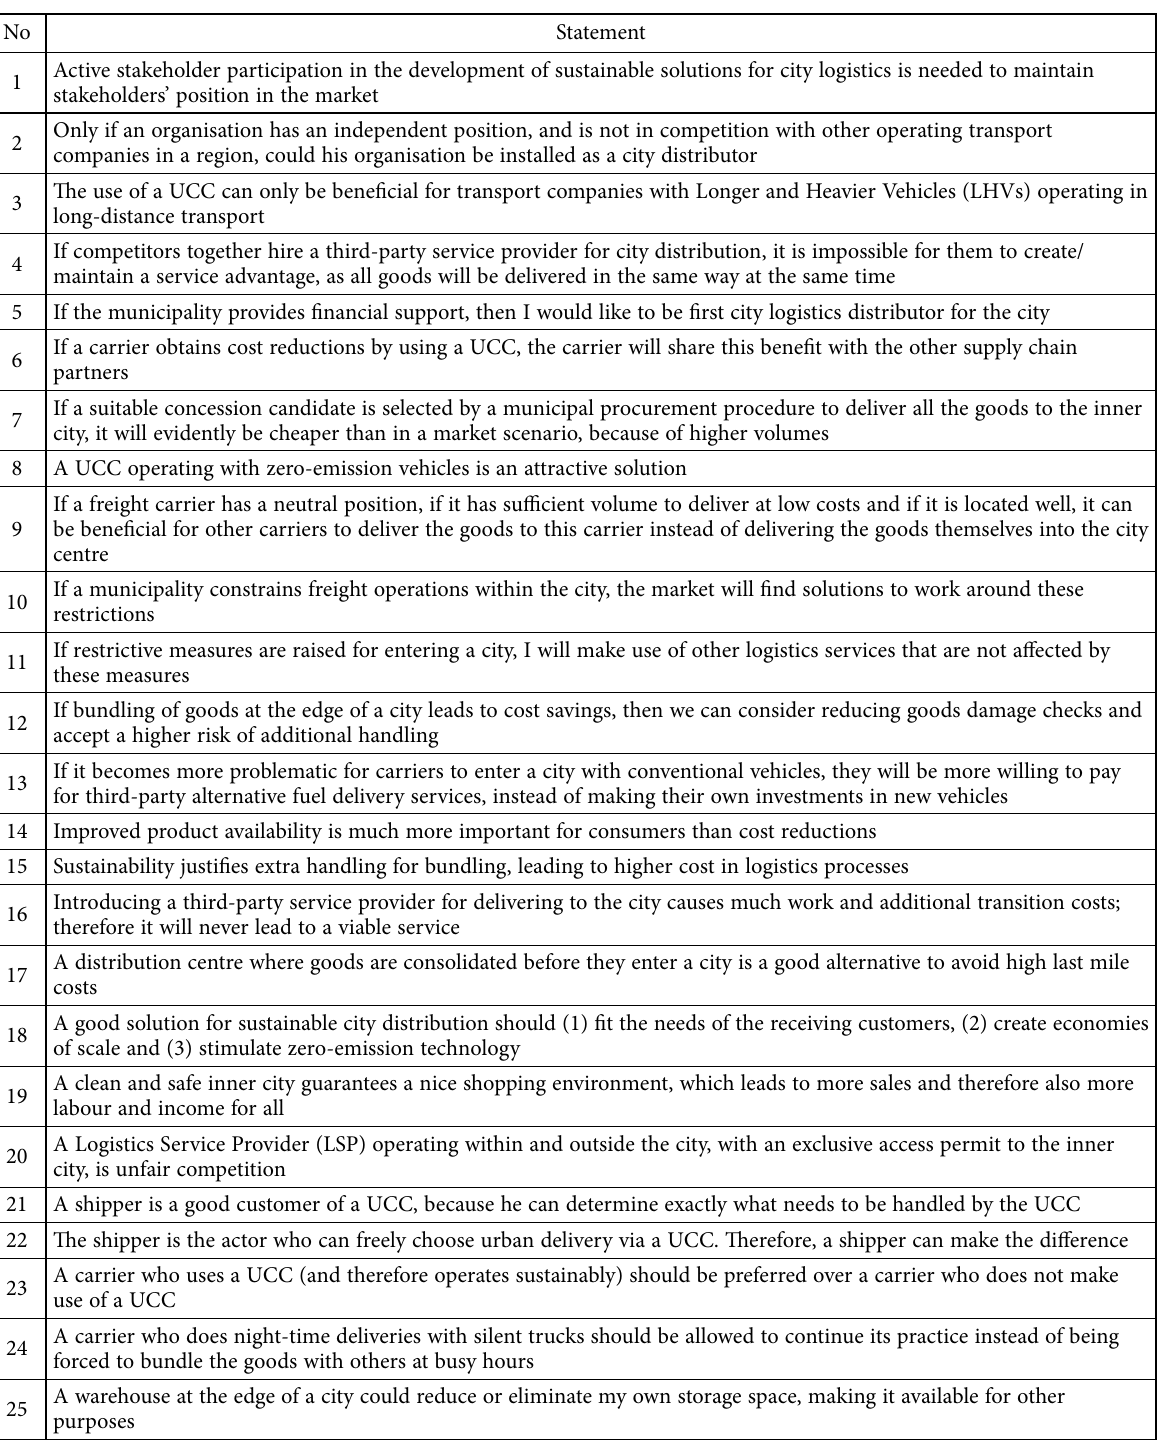
Table 1. Statements in the